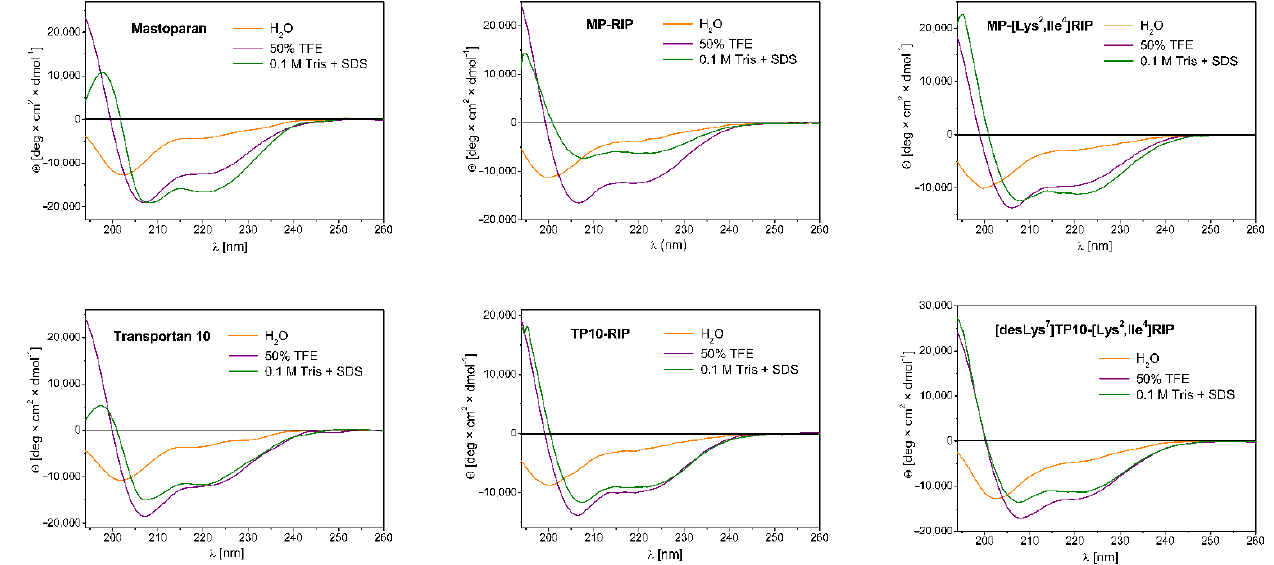
Figure 2. Examples of CD spectra in water (orange line), 50% TFE (purple line) and 0.1 M Tris buffer with the addition of 50 mM SDS (olive line) for MP and its selected analogs.